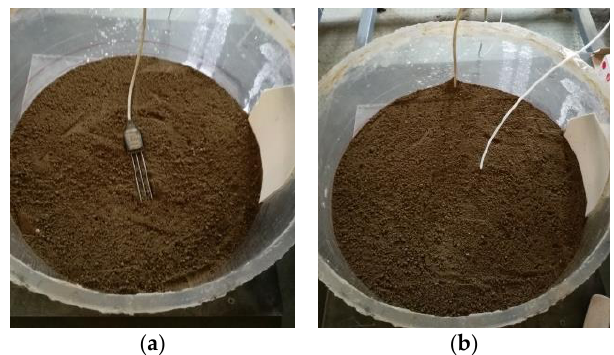
Figure 3. Location of sensors. ( a ) TDR (Time Domain Reflectometry) probe. ( b ) Tensiometer.